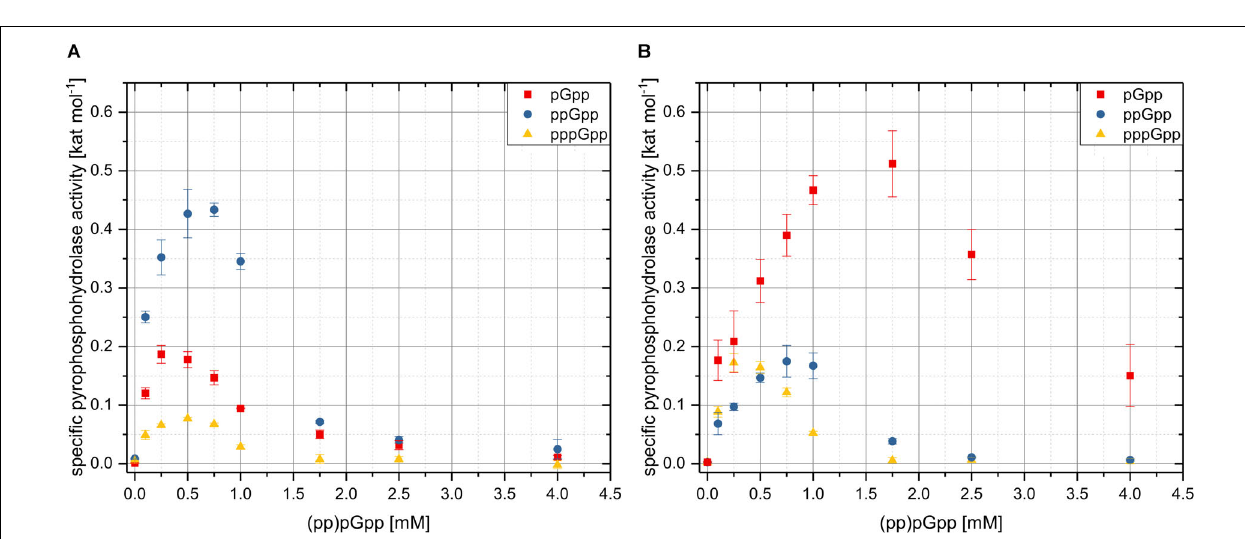
FIGURE 5 | Kinetics of RelH Cg (A) and Rel Cg (B) using pGpp, ppGpp and pppGpp as substrates. Specific activities were determined for different substrate concentrations by in vitro analysis and given in kat per mol of the respective enzyme. The reaction mixtures contained 50 mM HEPES-Na (pH 8.0), 200 mM NaCl, 1 mM MnCl 2 as well as 52.3 nM RelH Cg or 98.2 nM Rel Cg , respectively. The incubation times of the different enzyme-substrate combinations were adapted to the values determined in preliminary tests and ranged from 20 to 45 min. The incubation temperature was 30 ◦ C. Mean values and standard deviations shown were calculated from three